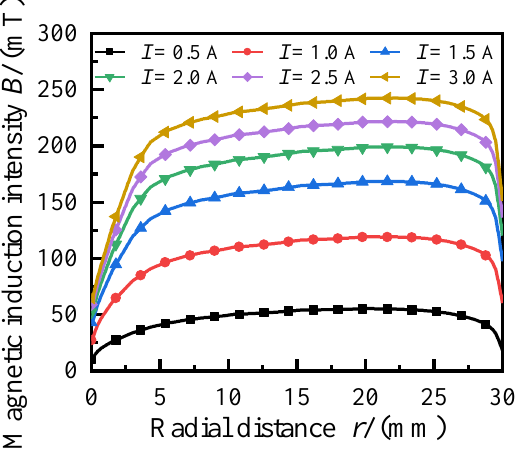
Figure 9. Relations among current, working gap radial distance, and magnetic induction intensity. The radial distance from any plane of the MRF to the small diameter is defined as r .